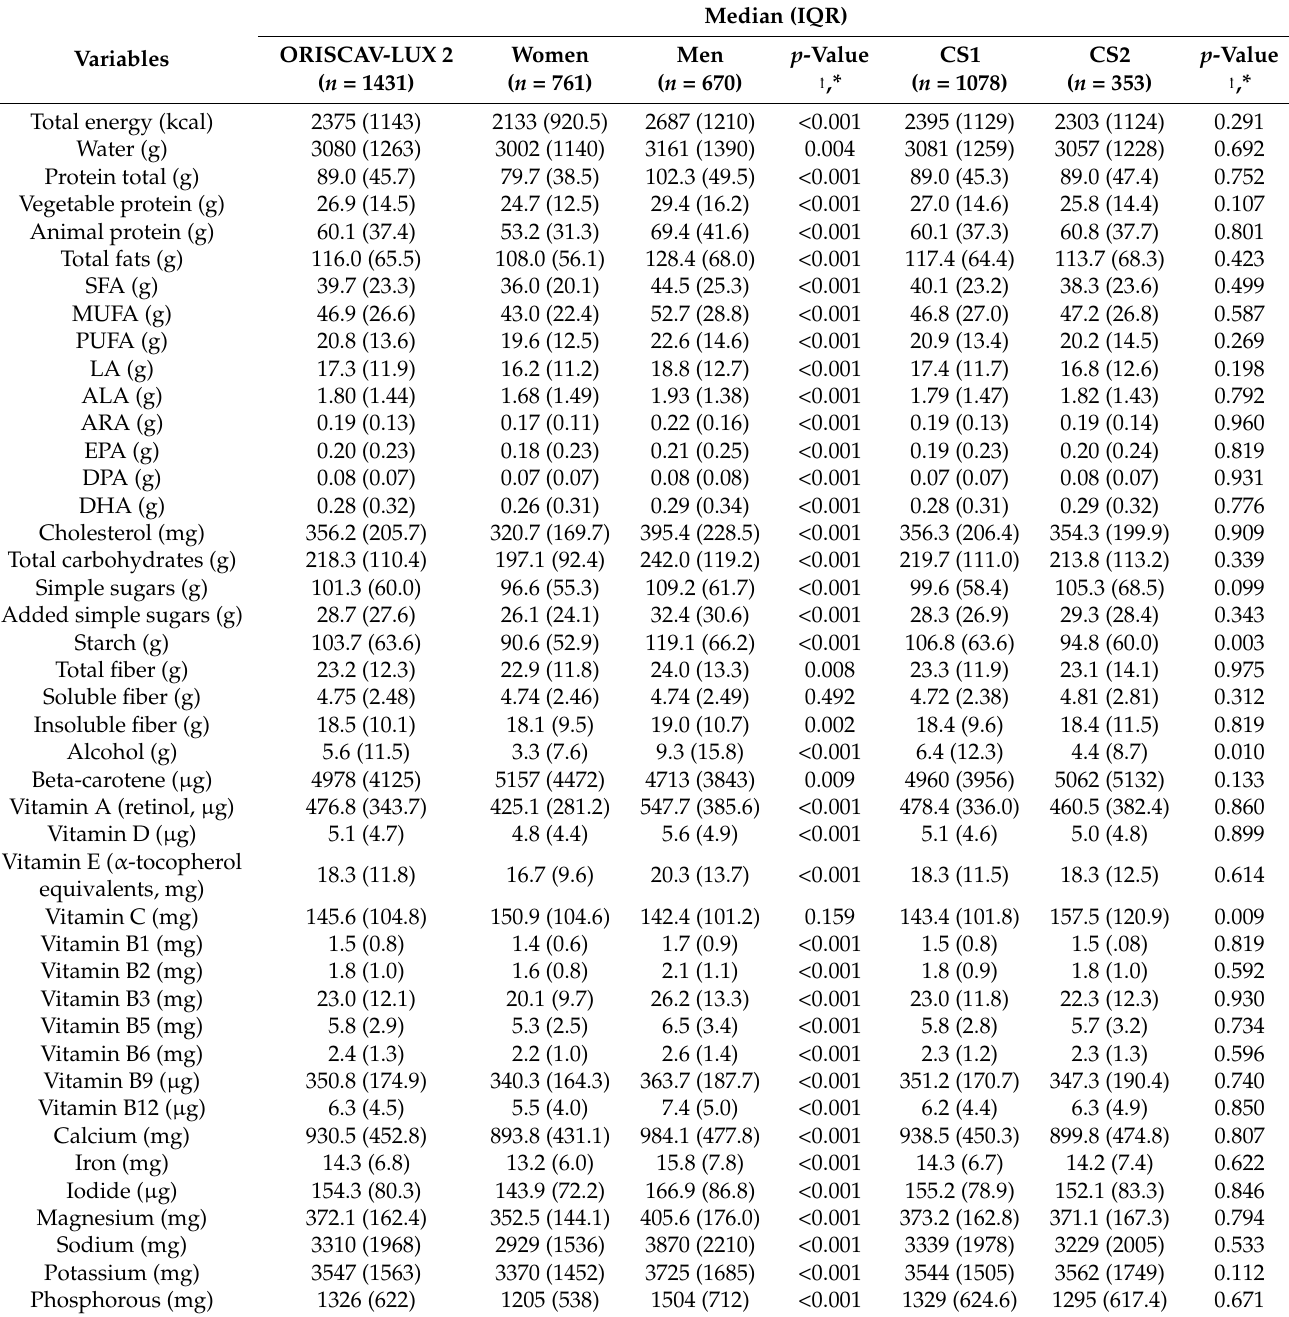
Table 4. Distribution (median and IQR) of nutrient intake per day according to gender and constipa- tion score groups.